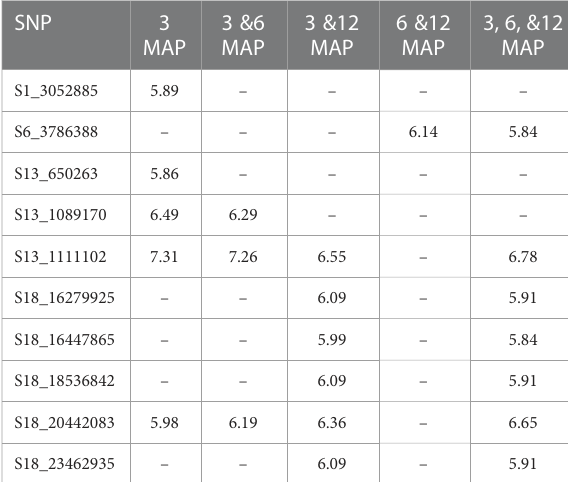
(Table 5). Control of population structure effects on the associations were validated using Q-Q plots where the observed -log 10 (P-value) was close to the expected -log 10 (P- value) at -log 10 (P-value)< 2.0 but at the tail of the distribution the dots deviated from the observed value thus indicating that signi fi cant associations were identi fi ed (Supplementary Figures 2 and 3). In the univariate analysis, 5 associations were reported only for CBSDs3 on chromosomes 1, 13 and 18 (Figure 2). SNPs in these three genomic regions explained 19.1% of the observed phenotypic variation compared with other SNPs in the genome